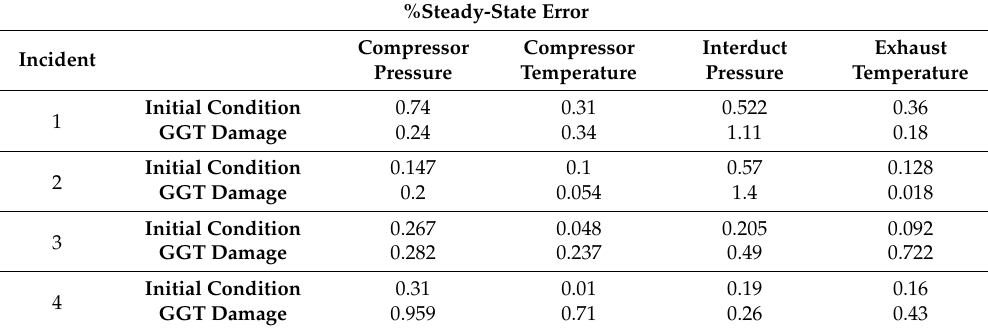
Figure 25. Measured, fitted and simulated compressor discharge temperatures. Table 5. Error between fitted and simulated data for compressor discharge temperature, compressor discharge pressure, interduct pressure, and exhaust temperature for the four GGT damage incidents at